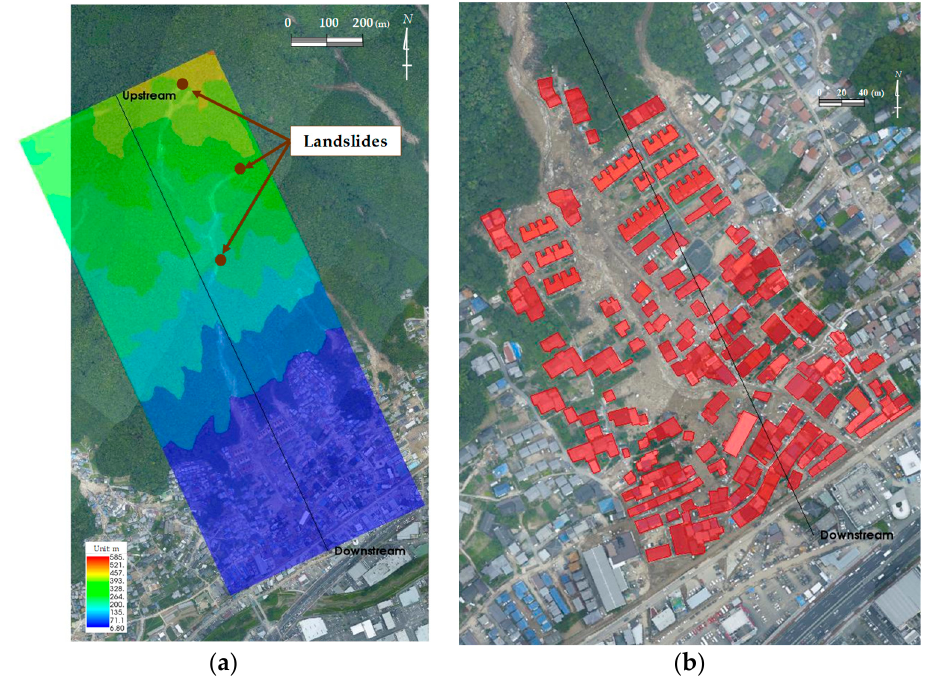
Figure 13. The calculation domain and polygons of houses and buildings. ( a ) Calculation domain, ( b ) Polygons of houses and buildings. The colored contours in ( a ) indicate the spatial distribution of the land elevation. The brown circles indicate the locations of the landslides used in these analyses.